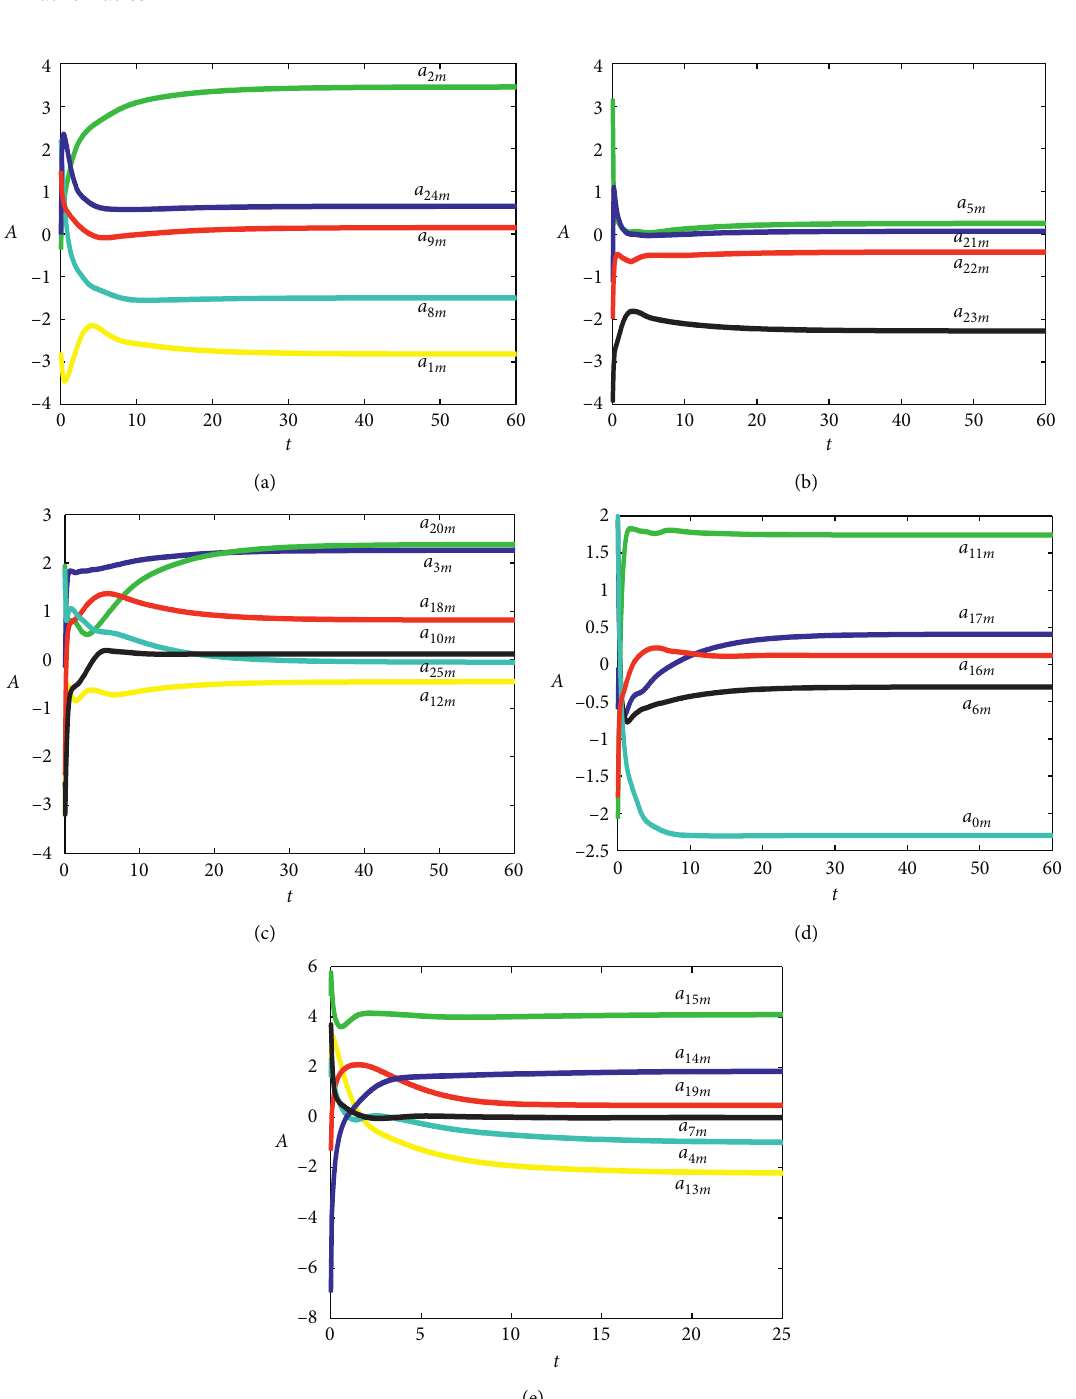
,a , ... ,a for neural network (53) and (54) in Example 0 m 1 m 25 m